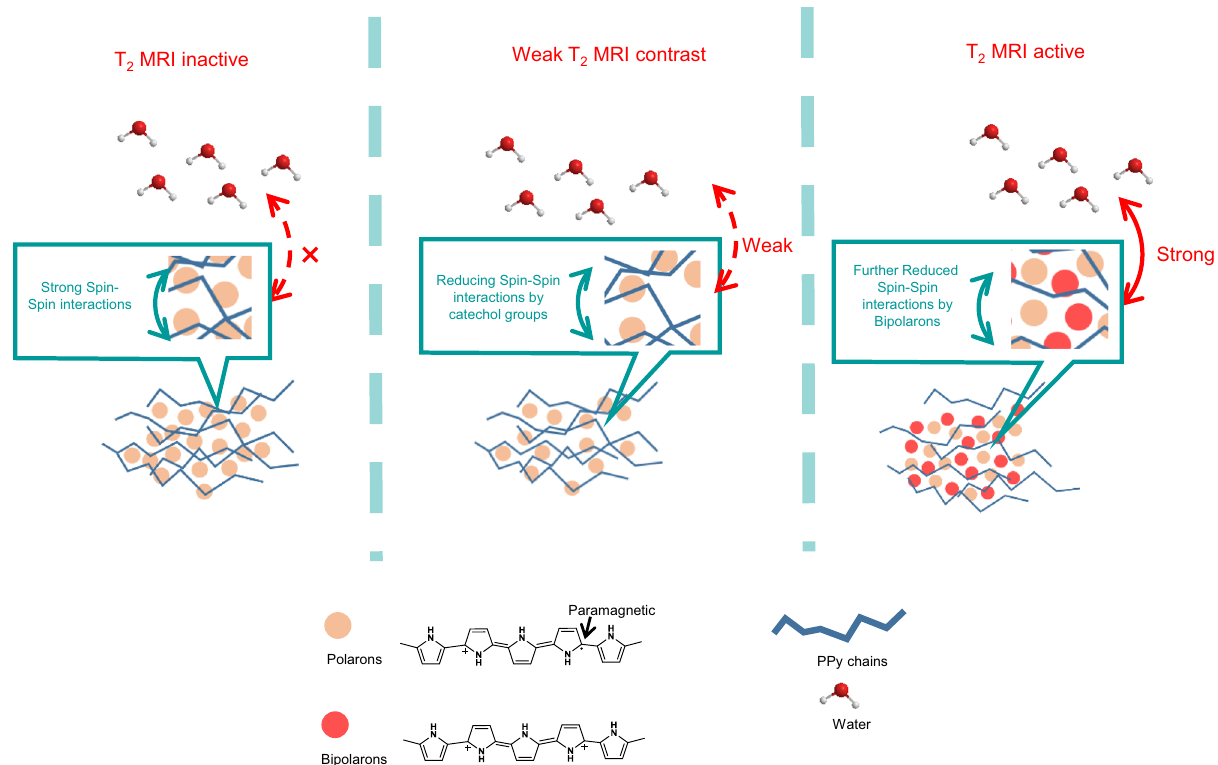
Fig. 2 Schematic illustration of the “ partially complexed ” method for activating conjugated polymer nanoparticles in T 2 MRI. For T 2 MRI inactive PPy nanoparticles, paramagnetic polarons are block from water protons by strong “ spin – spin ” interactions between polarons. For PPy nanoparticles with weak T 2 MRI contrast, above interactions are moderately reduced by catechol derivatives used in “ partially complexed ” method. For T 2 MRI active PPy nanoparticles, bipolarons further increase the interactions between paramagnetic polarons and water